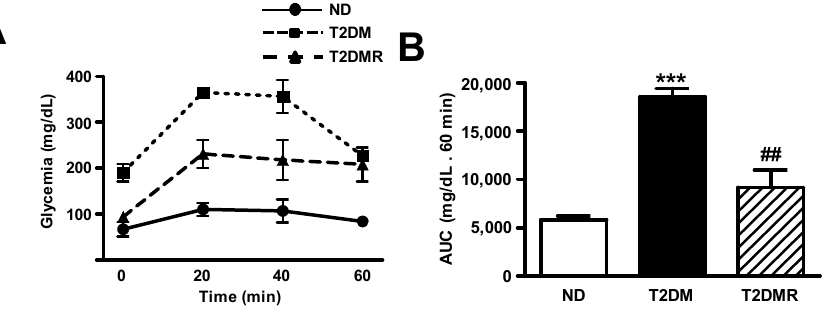
Figure 4. Resveratrol reduced in vivo gluconeogenic activity in T2DM mice. Blood glucose ( A ) and area under the curve (AUC) of blood evolution ( B ) during pyruvate tolerance test were analysed in non-diabetic (ND), type 2 diabetic (T2DM), and resveratrol-treated type 2 diabetic (T2DMR) mice. Data are expressed as mean ± SEM of 3 animals, and were analysed by one-way ANOVA with the Newman-Keuls post-test. *** p < 0.01 vs. ND; ## p < 0.05 vs. T2DM. 2.4. Resveratrol Attenuates mRNA Content of Pro-Inflammatory Cytokines in White Adipose Tissue